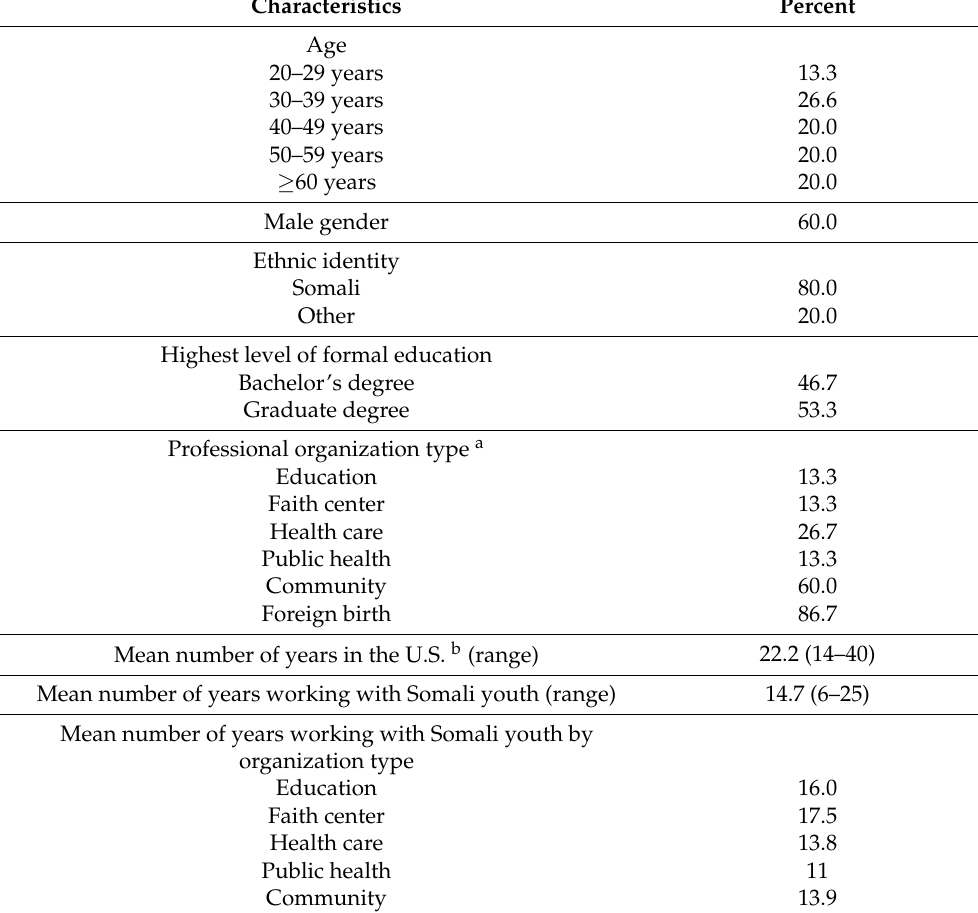
Table 1. Key informant demographic